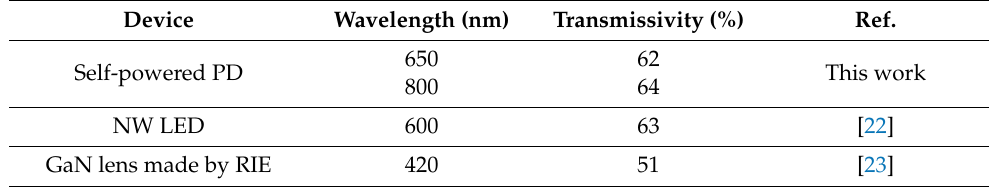
Figure 3. ( a ) PL spectra of (In,Ga)N NWs measured at room temperature; ( b ) transmission spectra of PD-B. The inset is the schematic illustrations of taking images through PD. Take the optical images ( c ) without PD and ( d ) with PD-B. Table 2. Comparison of the transmissivity between this work and other reported GaN-based devices.